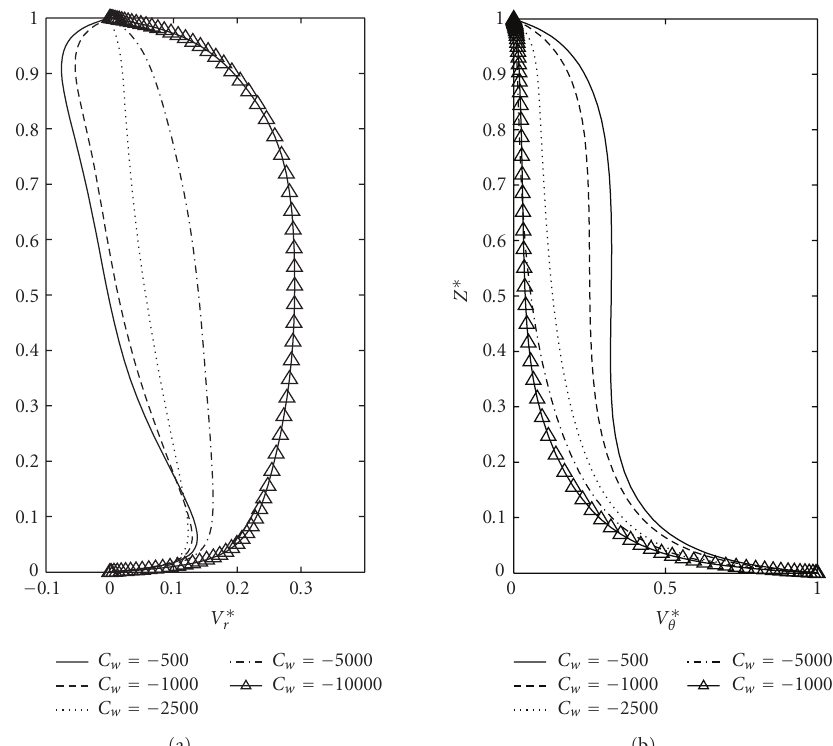
Figure 16: Axial profiles of the mean radial and tangential velocity components for Re = 10 6 , G = 0 . 02 at r ∗ = 0 . 57, and five flowrate coe ffi cients C w <